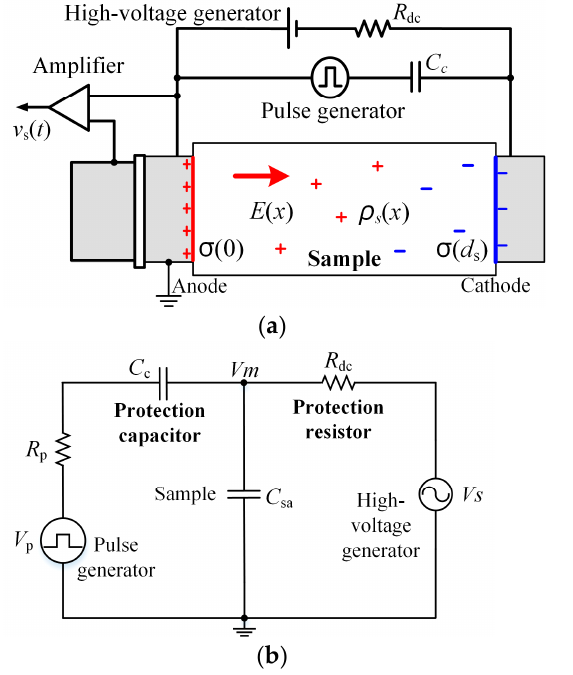
Figure 1. The PEA method for space charge measurement: ( a ) the measurement system, ( b ) the equivalent circuit.